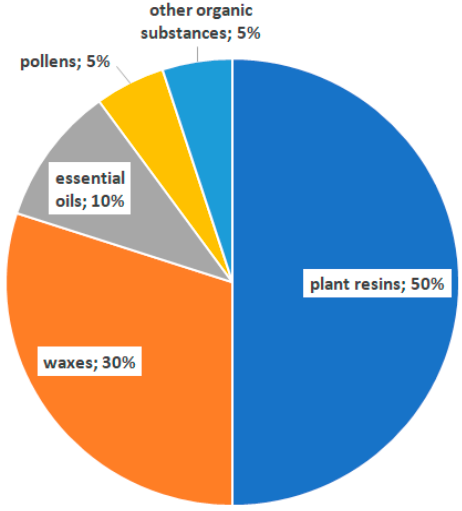
Figure 1. Composition of propolis.